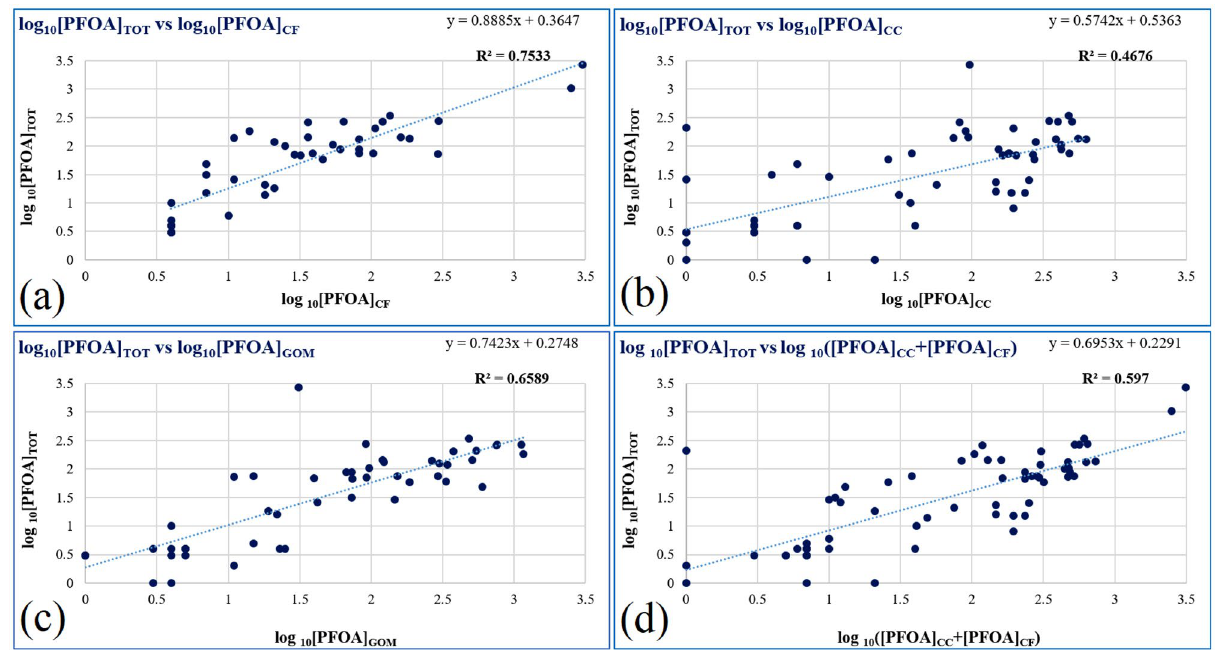
Figure 3. Correlation graphs between either log 10 [PFOA] in a type of matrix labelled as: ( a ) CF = Coelomic Fluid, ( b ) CC = Coelomocytes, ( c ) GoM = Gonads or Mixed organs (x-axis), ( d ) CC + CF versus the total concentration in the entire specimen expressed as log 10 [PFOA] TOT